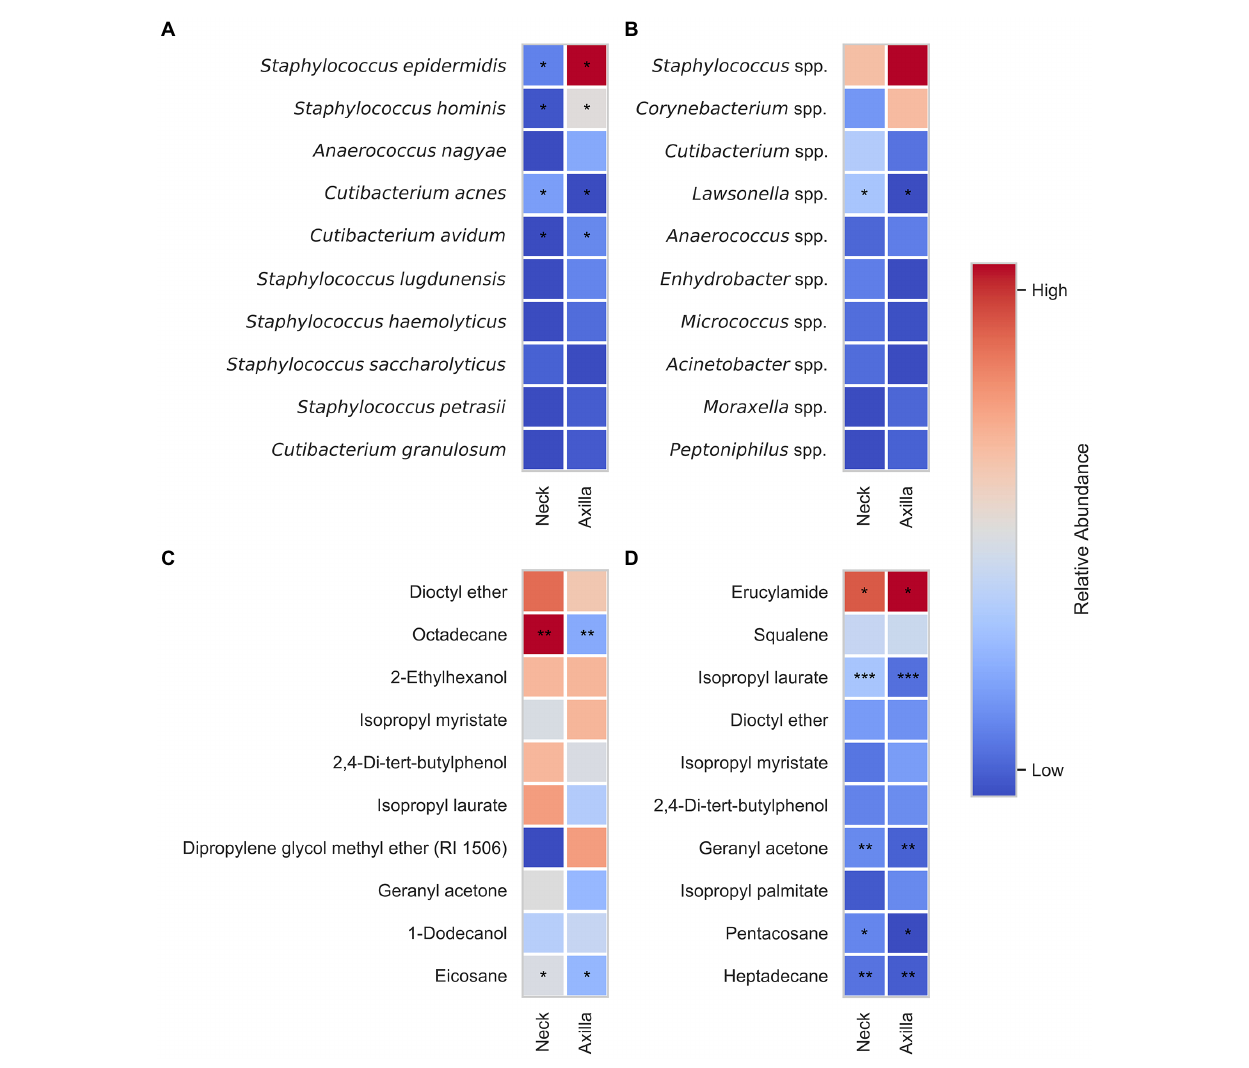
FIGURE 4 Relative bacteria abundance for culture data (A) and DNA data (B) as well as normalized peak areas from FFAP (C) and DB-5 (D) samples of armpit and neck. In total 40 samples were compared (10 armpit and 10 neck samples from each sampling round). The value in each cell is determined by the relative abundance of the respective bacteria, DNA data, or normalized peak areas averaged over all the subjects. Significant differences are highlighted with asterisk(s) (*) in the same column where *** denotes p < 0.001, ** denotes p < 0.01, and * denotes p < 0.05. For ASV data ( B ) significant differences calculated with differential abundance test using analysis of compositions of microbiomes (ANCOM) (Mandal et al., 2015) are shown with an asterisk